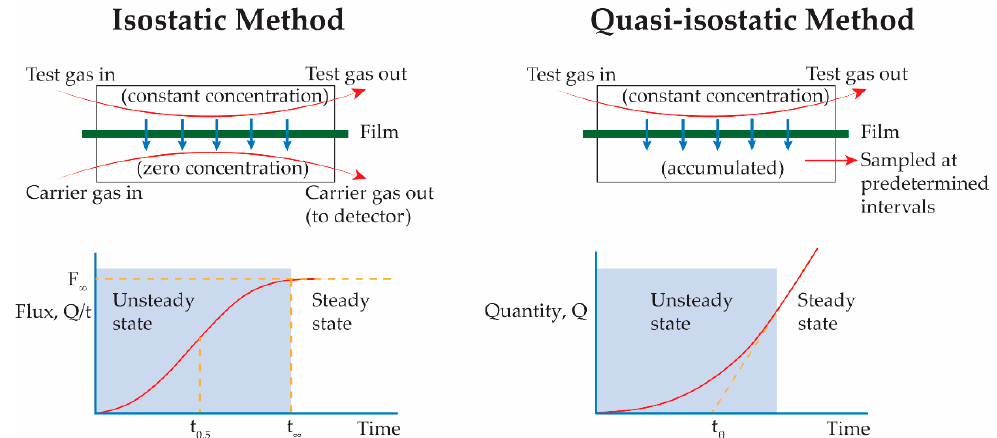
Figure 3. Schematic diagram and plot of common gas permeation measurement methods. In the quasi-isostatic (also known as time-lag) method, the downstream chamber is maintained in concentrations below 5 wt% of the upstream side throughout the test. Copyright 2018. Reproduced from [111] with permission from Elsevier Ltd. Table 3. Oxygen mass transport parameters (dry conditions) in epoxy polymeric structures from the literature data. Material Test